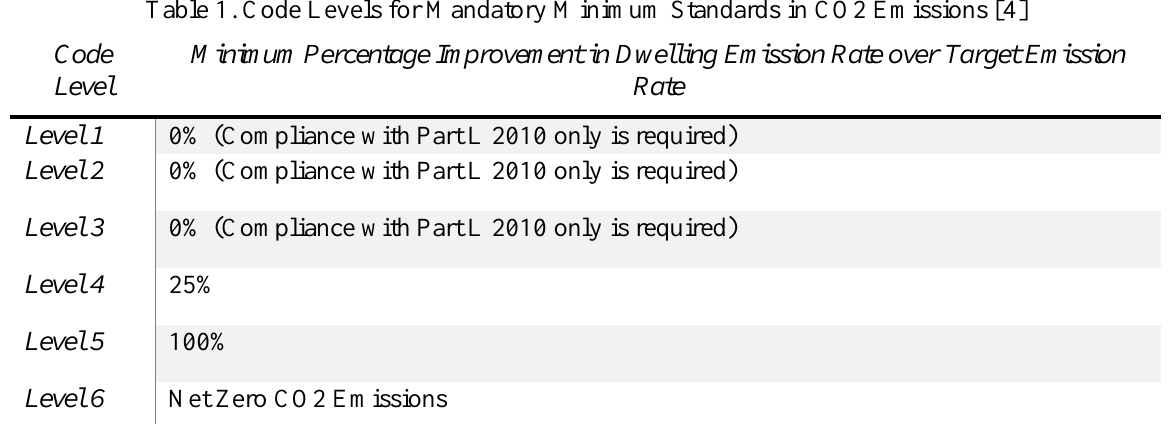
Table 1. Code Levels for Mandatory Minimum Standards in CO2 Emissions